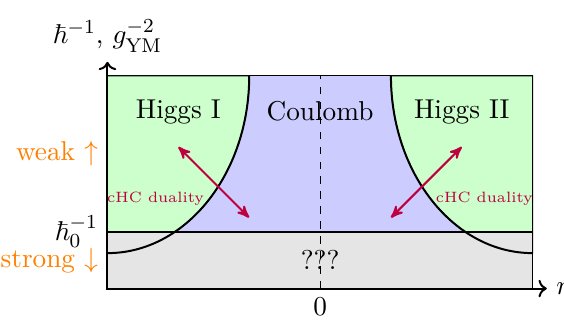
Figure 1 . Simple gauged sigma-model phase